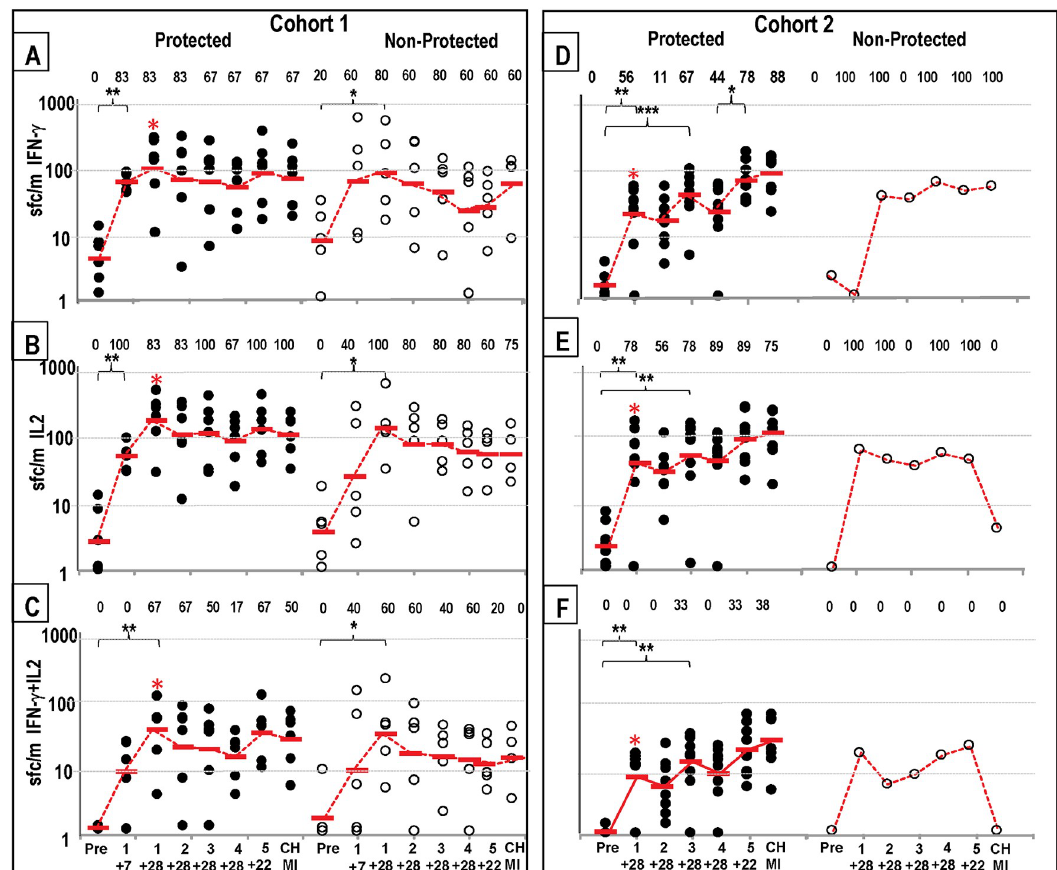
Fig 2. Cohorts 1 and Cohort 2: IFN- γ , IL2 and IFN- γ +IL2 activities to SPZ after each immunization and CHMI. IFN- γ , IL2, and IFN- γ +IL2 responses to SPZ (time points in Fig 1). Protected subjects (closed circles), non-protected subjects (open circles). Geometric means (red bars). Numbers are % positive subjects. Significant changes are shown by � p = < 0.05, �� p = < 0.01, ��� p = < 0.001. Red asterisk: Time points when differences between Cohort 1 and Cohort 2 were significant (p = < 0.05). Cohort 1: IFN- γ : Panel A: IFN- γ : responses of protected subjects significantly rose 7 days post-1 st , peaked 4 weeks post-1 st , were lowest post-4 th , rose post-5 th , and dropped post-CHMI. Responses of non-protected subjects also significantly rose 7 days post-1 st and peaked post-1 st , were unchanged post-5 th and rose post-CHMI; % positive subjects followed responses. Panel B: IL2 : the pattern of IL2 responses and % positive subjects were like IFN- γ responses except for a rise post-CHMI. Panel C: IFN- γ +IL2 : responses of protected subjects rose more slowly than IFN- γ and IL2 responses, dropped post-4 th , rose post-5 th in protected but not non-protected subjects and dropped post-CHMI. % positive subjects followed this pattern. Cohort 2: Panel D: IFN- γ : responses of protected subjects significantly rose 4 weeks post-1 st , post-3 rd , significantly rose again post-3 rd , and significantly rose and peaked post-5 th and slightly rose post-CHMI; responses of the single non-protected subject also peaked post-3 rd but did not rise post-5 th . Panel E: IL2 : responses of protected subjects were like IFN- γ responses, but responses of the non-protected subject declined post-5 th and post-CHMI. Panel F: IFN- γ +IL2 : responses of protected subjects were like IFN- γ responses; responses of the non-protected subject were negative. % positive subjects reflected IFN- γ responses. Red asterisk: Four weeks post-1 st IFN- γ , IL2 and IFN- γ +IL2 responses were each significantly higher (p = 0.025; p = 0.03; p = 0.03 respectively) than Cohort 2 post-1 st IFN- γ , IL2 and IFN- γ +IL2